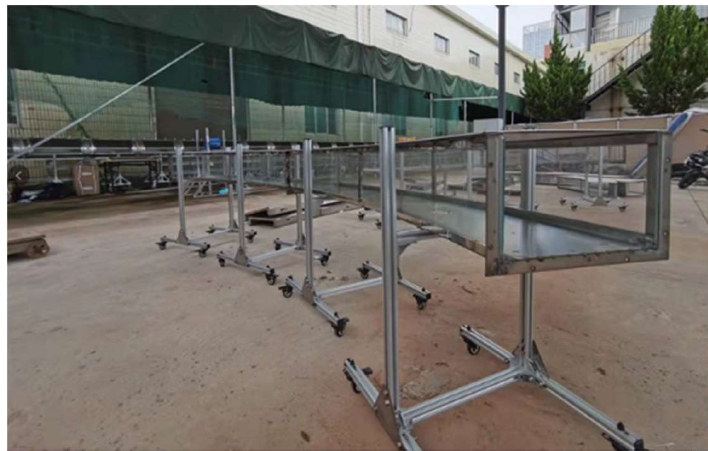
Figure 1. Apparatus of small-scale curved tunnel.